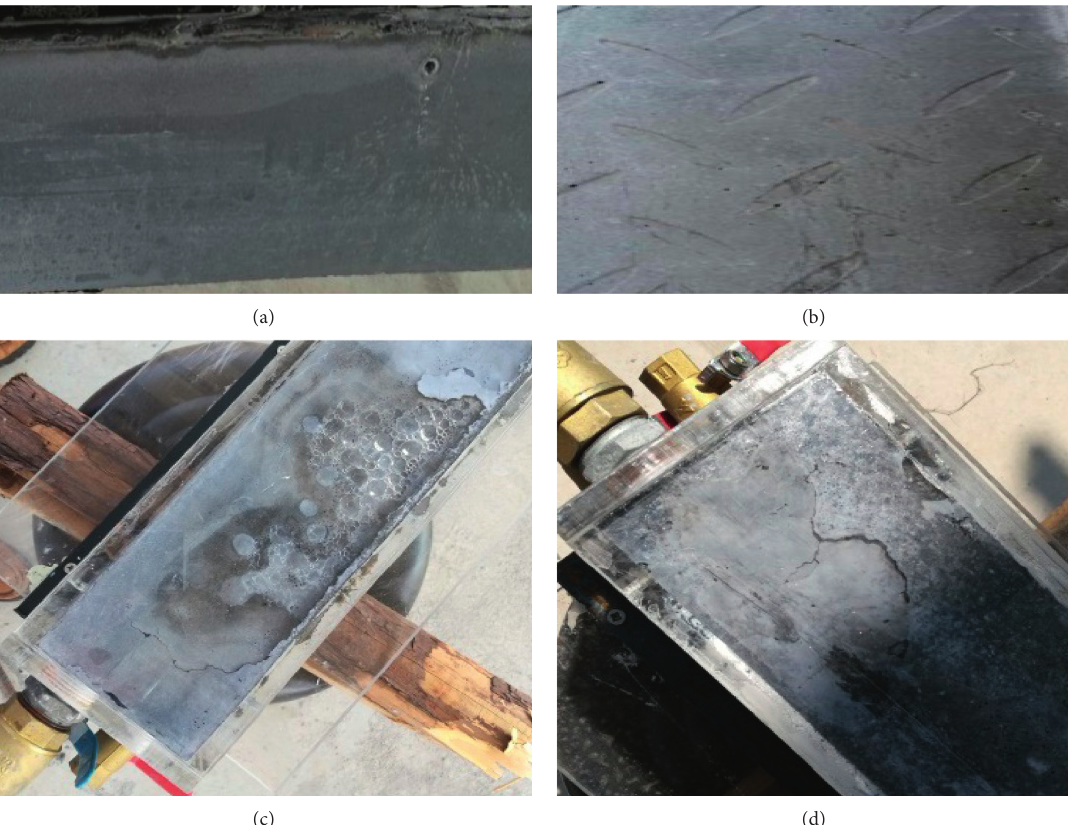
Figure 7: Inspection of quality of pressure grouting. (a) Interface of acrylic sheet. (b) Interface of steel plate. (c) Grout inlets. (d) Grout outlets.